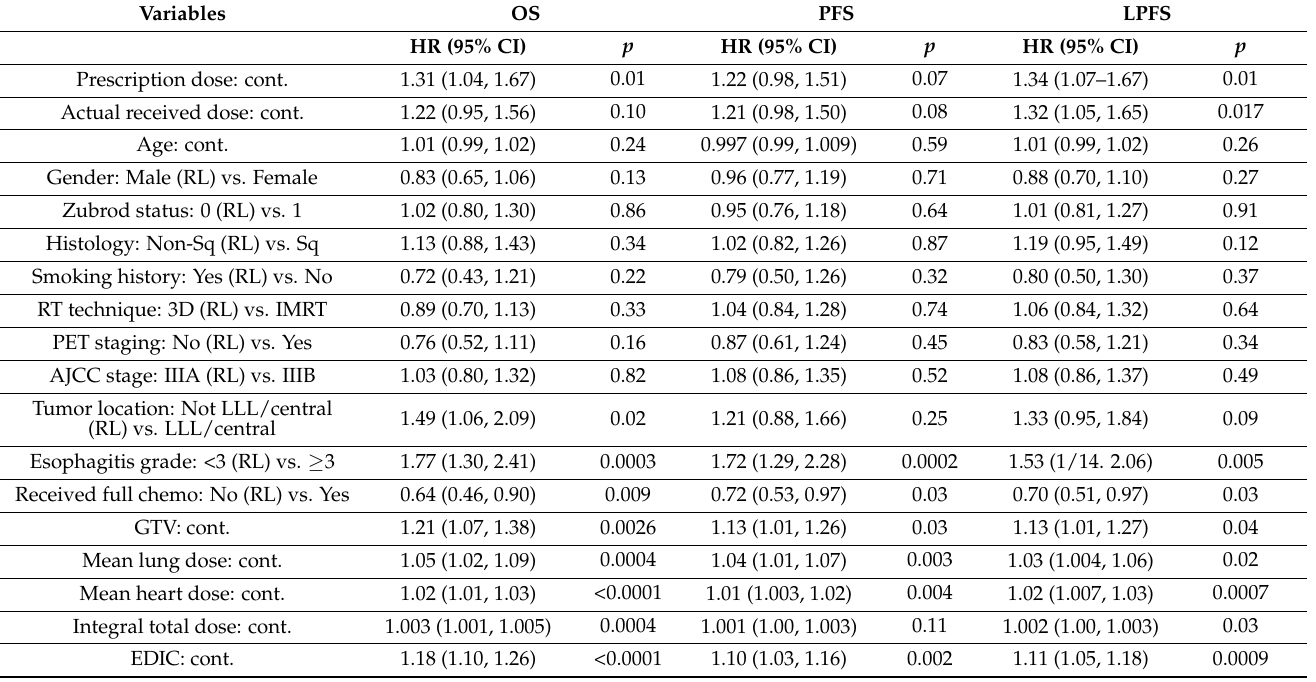
Table 1. Univariate analysis with stratification of patients by actual received RT dose